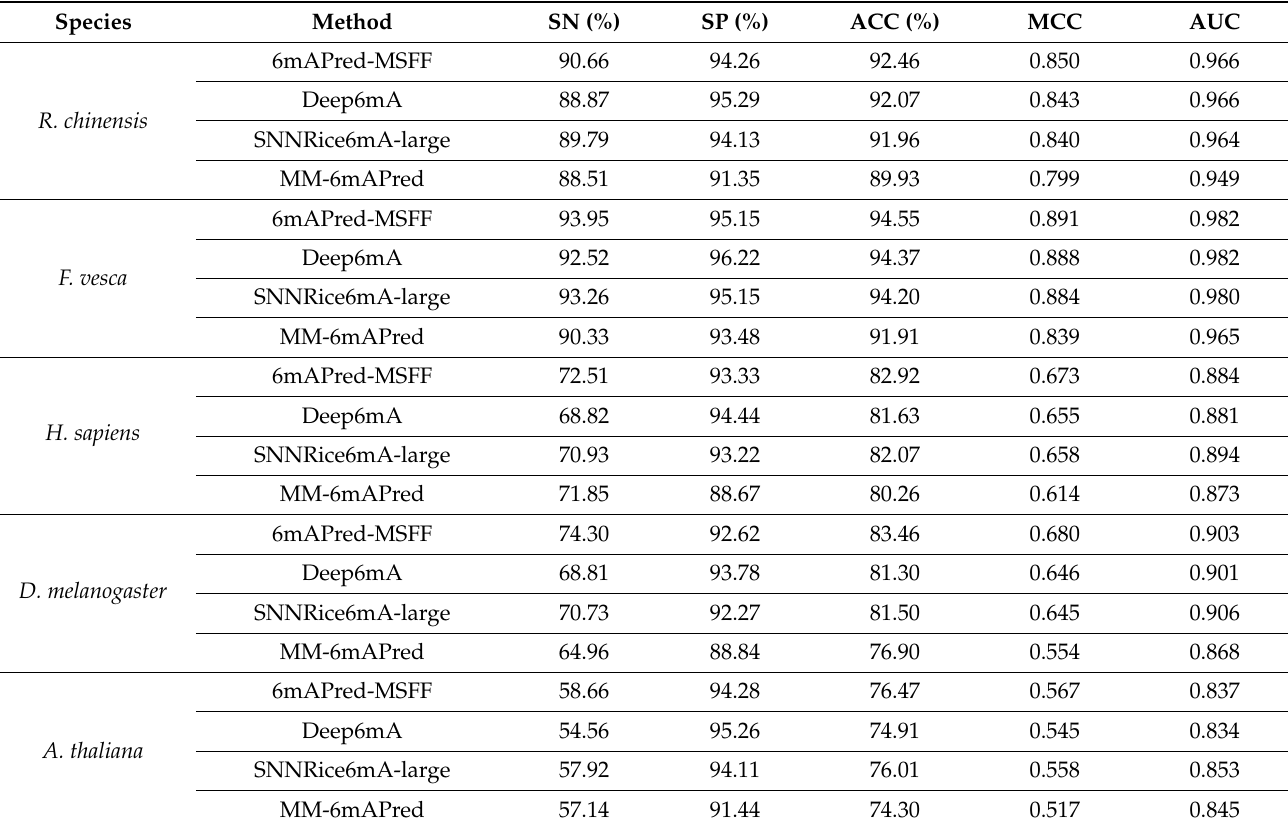
Table 3. Performance comparison of methods trained with the 6mA-rice-Lv dataset on cross species. Species Method SN (%) SP